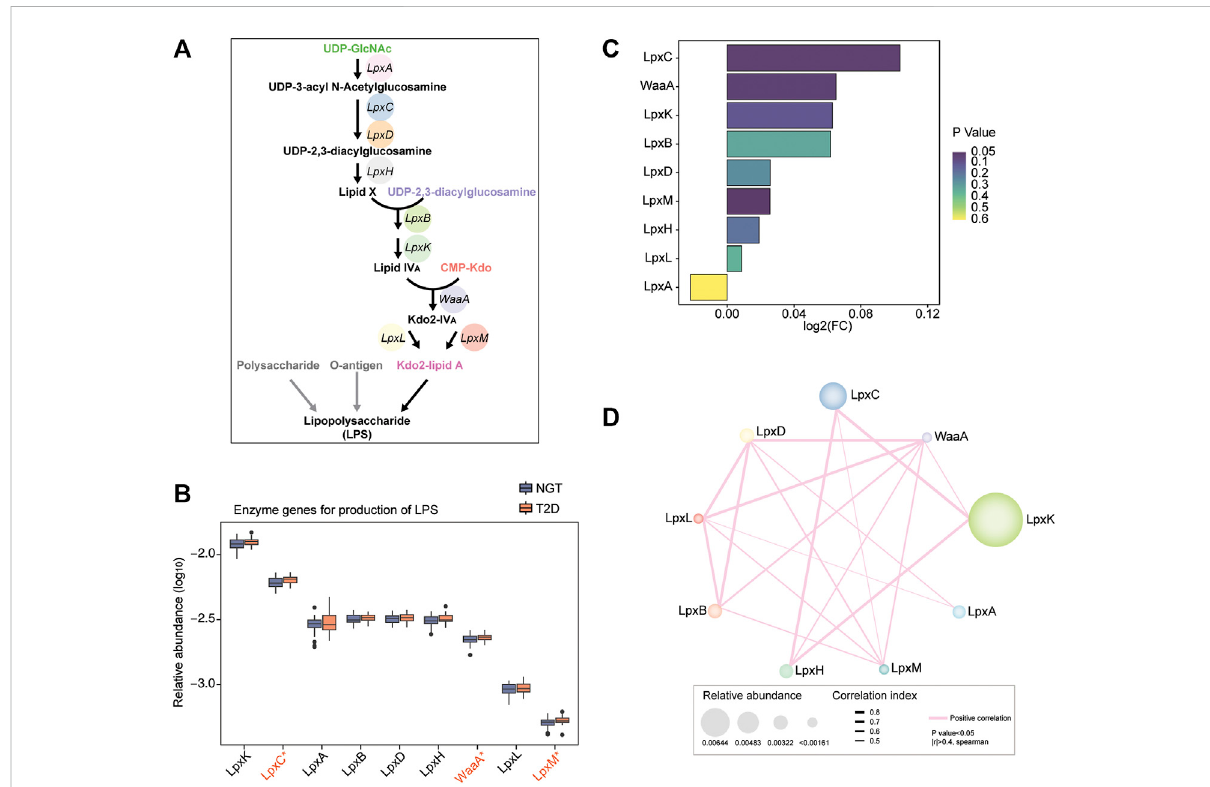
FIGURE 1 RelativeabundanceofLPS-biosynthesis-relatedenzymesinthegutofindividualswithNGTandpatientswithT2D. (A) Schematicdiagramofthe direct synthetic process and transformation pathways for LPS biosynthesis. Key enzymes catalyzing the progress from UDP-GlcNAc to Kdo2-lipid A were crucial and necessary for LPS biosynthesis, and genes encoding these enzymes were targeted for exploring their abundance. LpxA, UDP-N- acetylglucosamine acyltransferase; LpxC, UDP-3-O-[3-hydroxymyristoyl] N-acetylglucosamine deacetylase; LpxD, UDP-3-O-[3- hydroxymyristoyl] glucosamine N-acyltransferase; LpxH, UDP-2,3-diacylglucosamine hydrolase; LpxB, lipid-A-disaccharide synthase; LpxK, tetraacyldisaccharide 4 ′ -kinase; WaaA, 3-deoxy-D-manno-octulosonic-acid transferase; LpxL, Kdo2-lipid IVA lauroyltransferase/acyltransferase; LpxM, lauroyl-Kdo2-lipid IVA myristoyltransferase. (B) Box plots depicting the relative abundance levels of LPS-biosynthesis-related enzymes between individuals with NGT and patients with T2D based on the genes encoding the enzymes (orange, T2D; blue, NGT). Boxes represent the interquartile ranges; the inside lines indicate the median; circles are outliers, and red asterisk represents statistical difference at p < 0.05 (Wilcoxon rank-sum test). (C) Enrichment of LPS-producing enzymatic genes according to the encoding genes was evaluated using Log2 (fold change T2D/ NGT,FC).Log2(FC) > 0andLog2(FC) < 0indicatetheenrichmentofenzymesinpatientswithT2DandindividualswithNGT,respectively.Thecolors from dark purple to light yellow indicate the scales of p -value. (D) Co-occurrence network of the LPS-biosynthesis-related enzymes in the study cohort. The numbers labeled in the enzymes indicate the number of connections with others. The thresholds calculated via Spearman ’ s correlation analyses were p -value < 0.05 and | r | > 0.4. The pink lines connecting two enzymes denote a positive correlation. Line thickness and node size represent the| r | value of correlation and relative abundanceof enzymaticgenes, respectively. T2D, type2 diabetes;